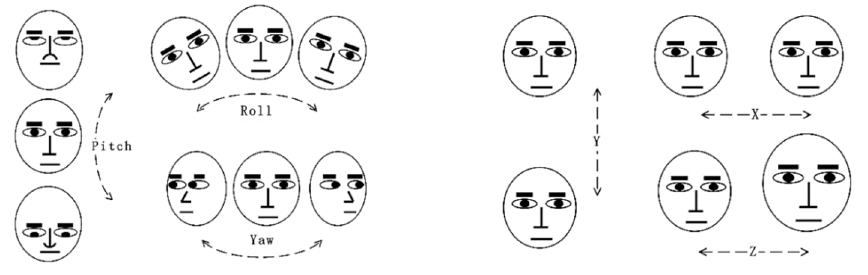
Figure 3. Estimated parameters of head posture.